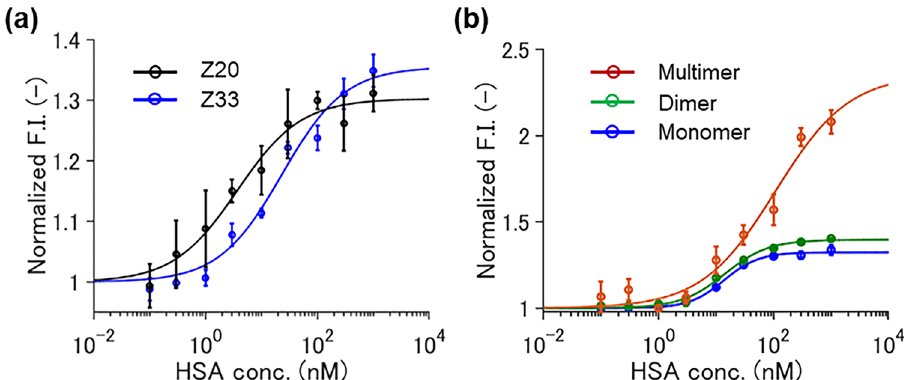
Figure 5. Dose–response curve of 5-TAMRA C6-labeled mini Q-body using selected nanobodies expressed by E. coli at 0–1 µM HSA. ( a ) Z20 and Z33 ( b ) Z33 at the state of one molecule (monomer), two proximate molecules (dimer) and multiple molecules captured on beads (multimer). Error bars represent ± 1